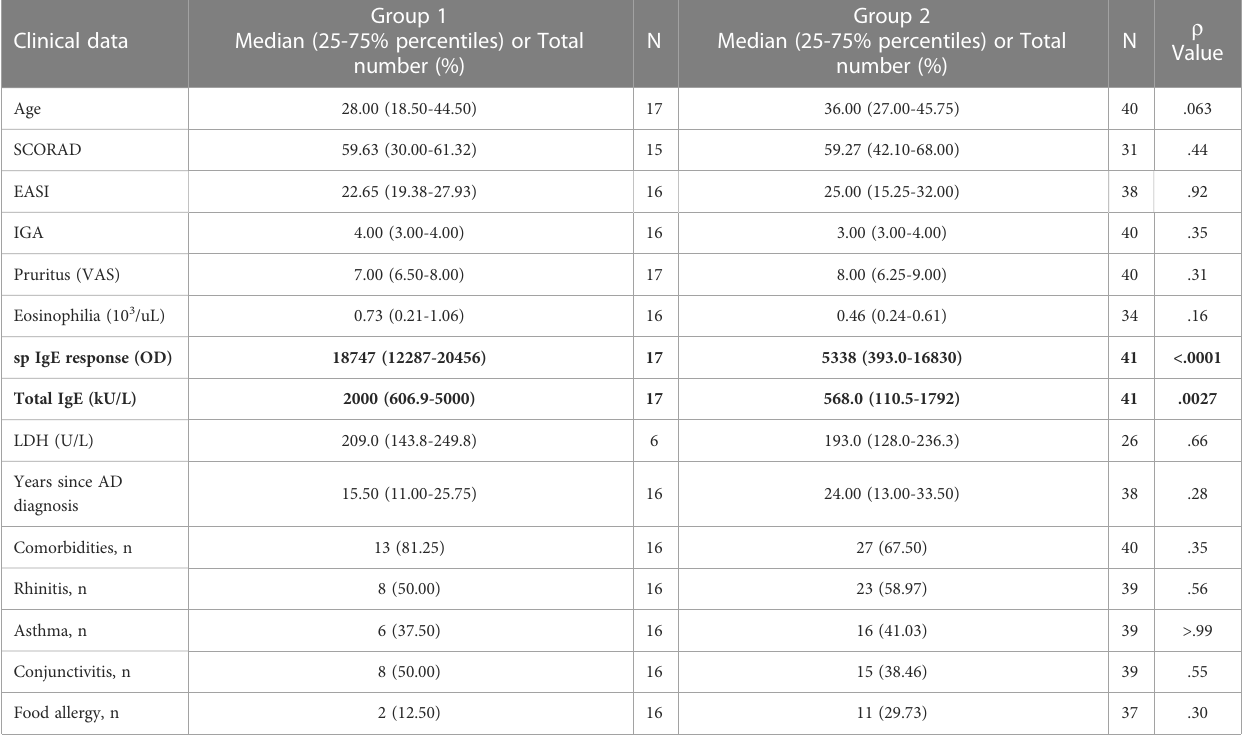
TABLE 1 Differences in clinical characteristics between group 1 and group 2.